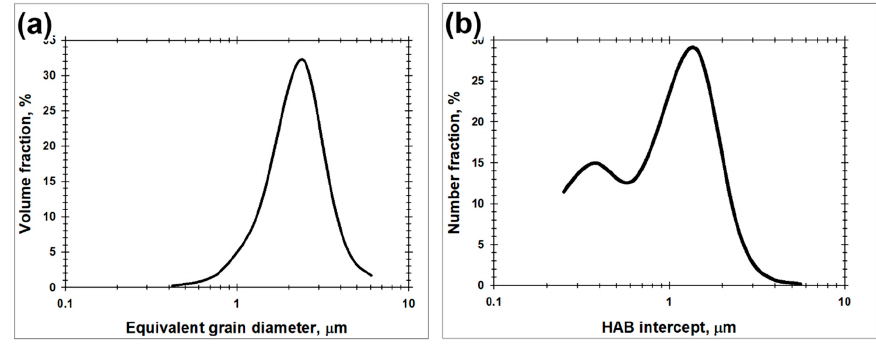
Figure 5. Grain-size distributions for the α phase measured by ( a ) the grain-reconstruction approach and ( b ) the grain-boundary intercept method from the EBSD map in Figure 4b.